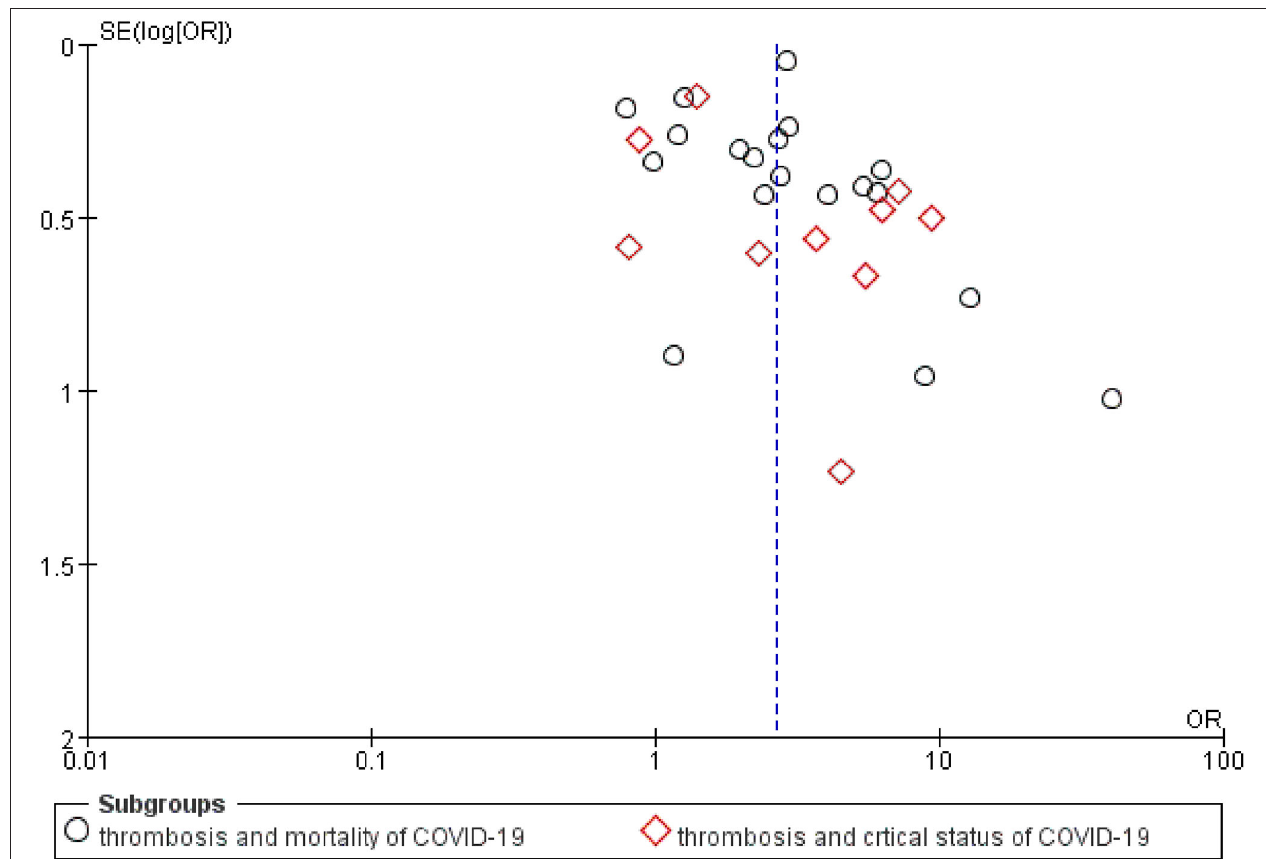
FIGURE 3 | A funnel plot of public bias of the association between thrombosis and prognosis of